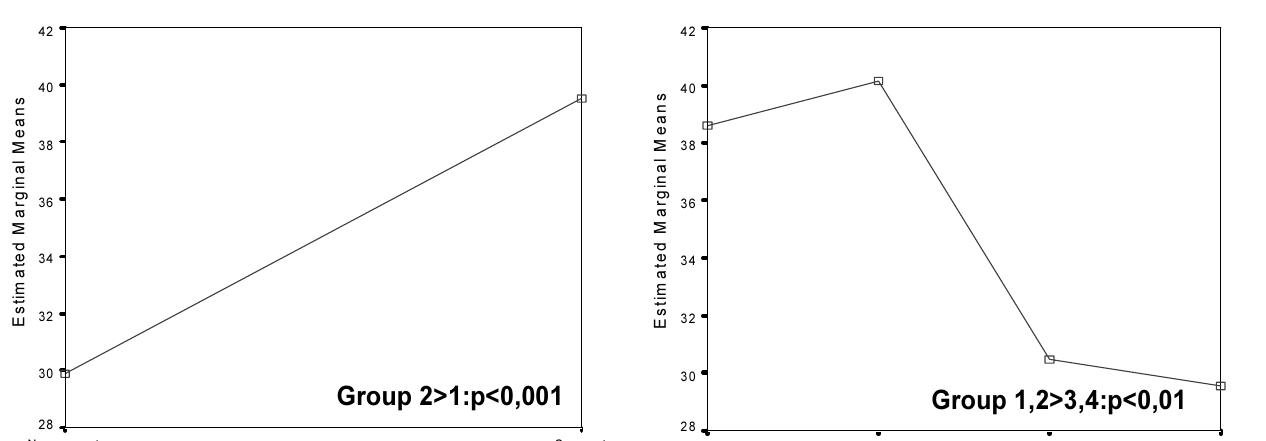
Group 2>1:p<0,001 Group 1,2>3,4:p<0,01 Figure 5: Outplacement support Figure 6: Job search stress